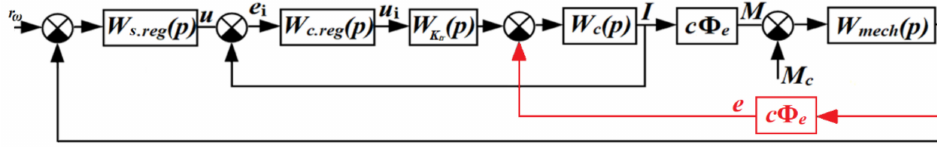
Figure 1. DC drive cascade control system